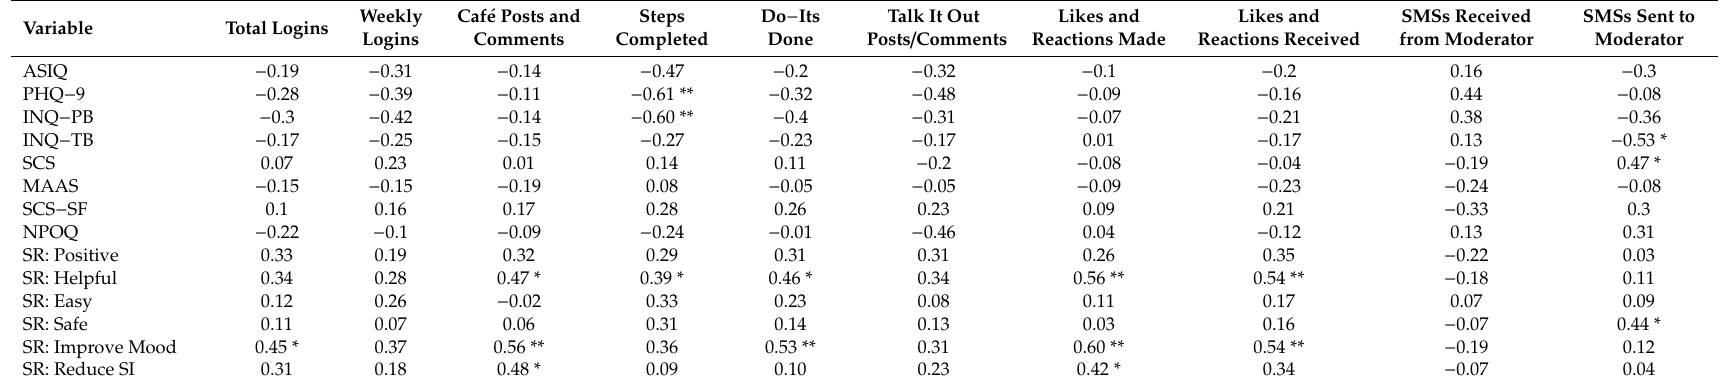
Table 6. Exploratory non-parametric correlations between change in clinical outcomes, subjective ratings of A ffi nity, and key domains of A ffi nity